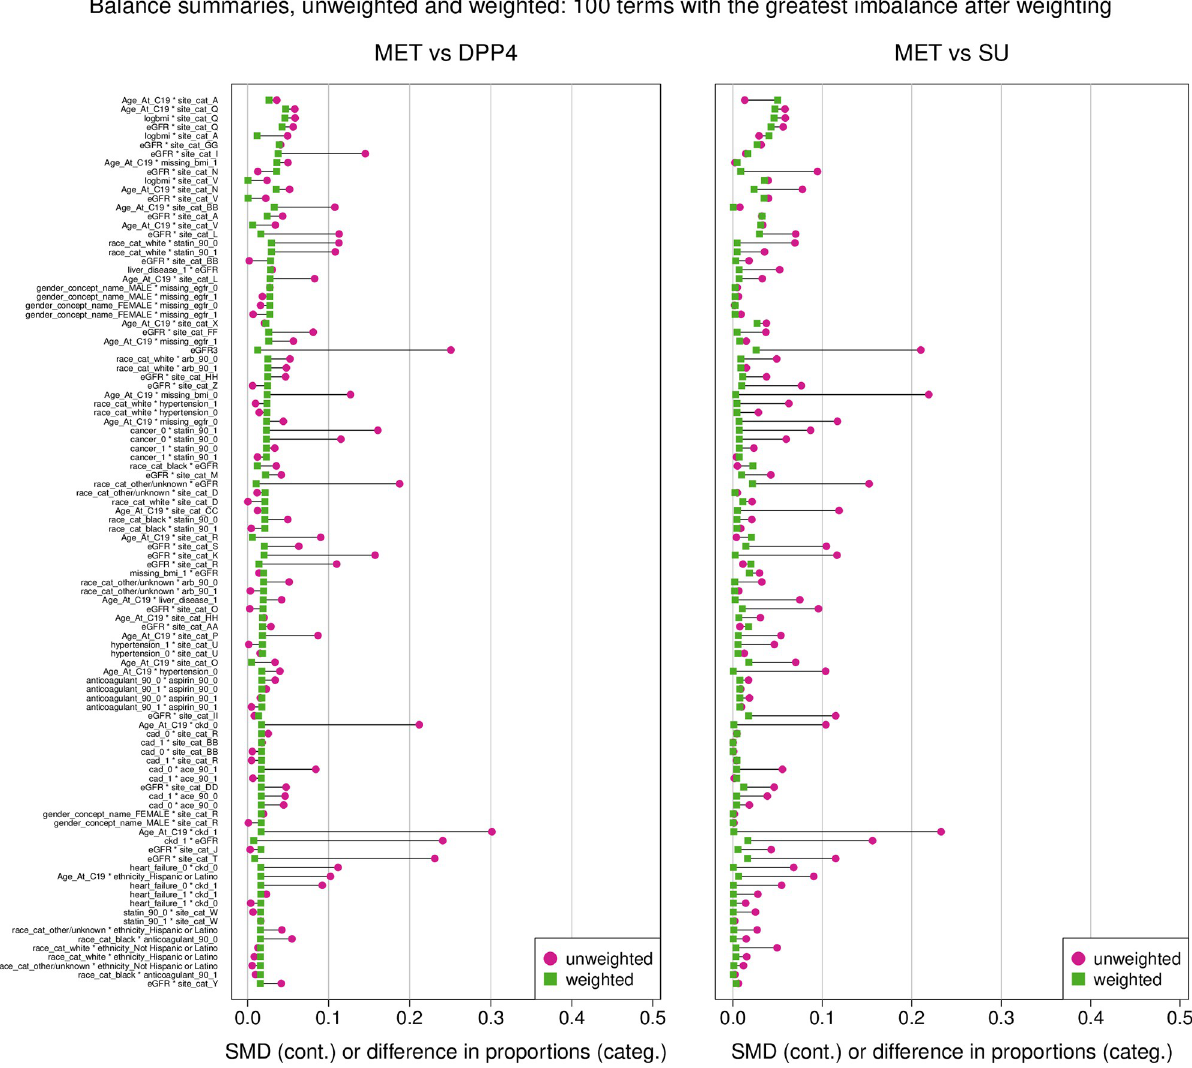
Fig 2. The x axis the standardized mean difference for continuous variables and difference in proportions for categorical variables for the 100 terms with the greatest imbalance after weighing. The circles represent the balance before weighting and the squares represent the balance after